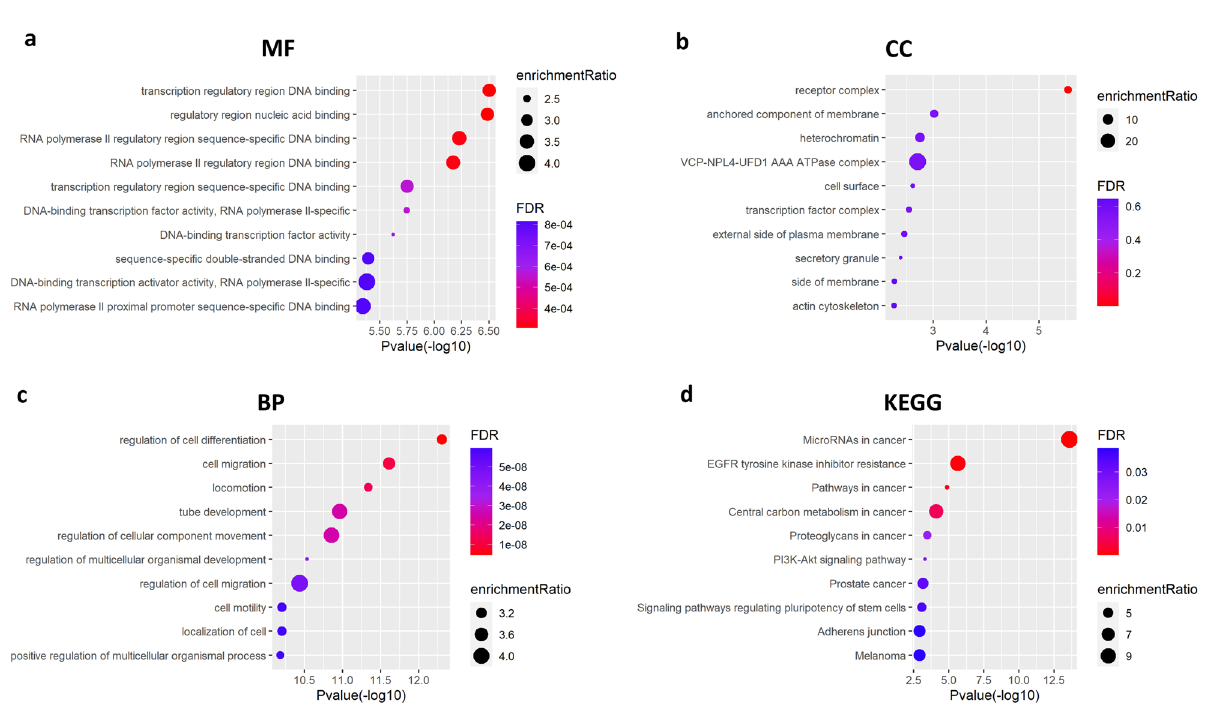
Figure 7. GO annotation and KEGG pathway enrichment analysis of the DE mRNAs in the ceRNA network. The top 10 enriched GO ( a ) MF, ( b ) CC and ( c ) BP terms as well ( d ) KEGG pathways. GO, gene ontology; KEGG, Kyoto Encyclopedia of Genes and Genomes; MF, molecular function; CC, cellular component; BP, biological